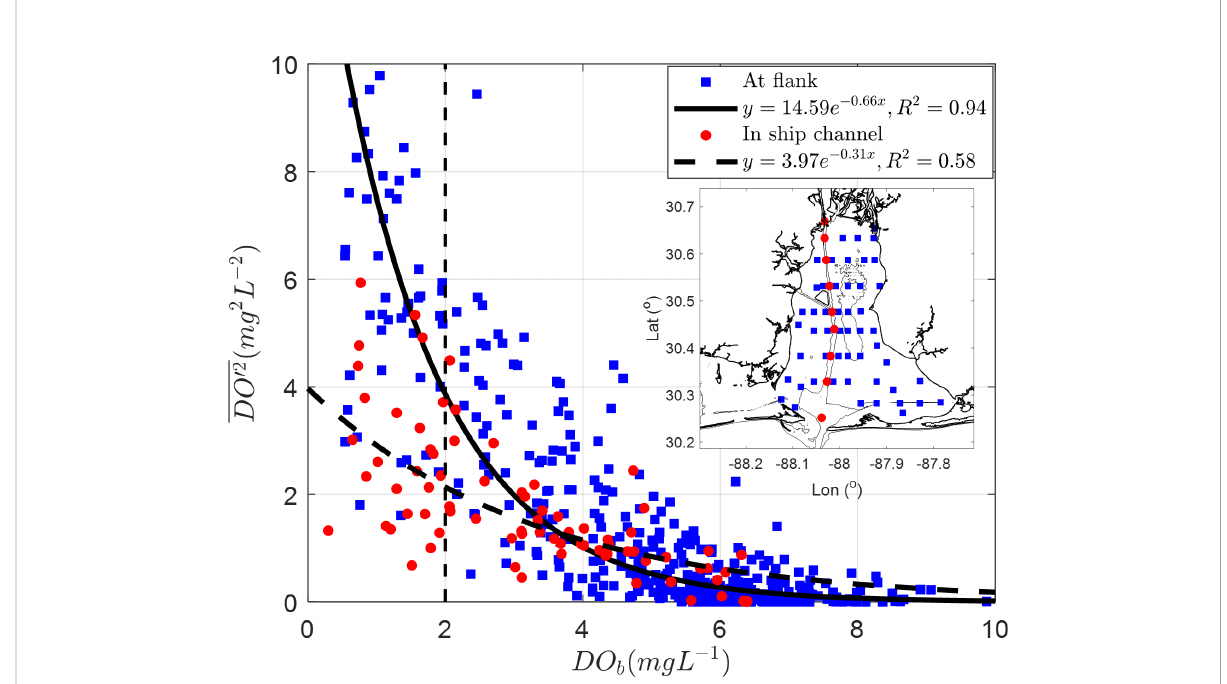
FIGURE 6 Relationship between depth averaged VDOV, DO 0 2 and DO b was computed from DO concentration pro fi les collected in Mobile Bay from April to August, from 0.6 m below surface to the bottom (Coogan et al., 2021). The subpanel denotes map of DO pro fi le stations. Blue squares are from 465 pro fi les collected in areas outside of the shipping channel (i.e., fl anks), and the solid black line is an exponential fi t to these data. Red circles are from 80 pro fi les collected in the shipping channel, and the black dashed line is their corresponding fi